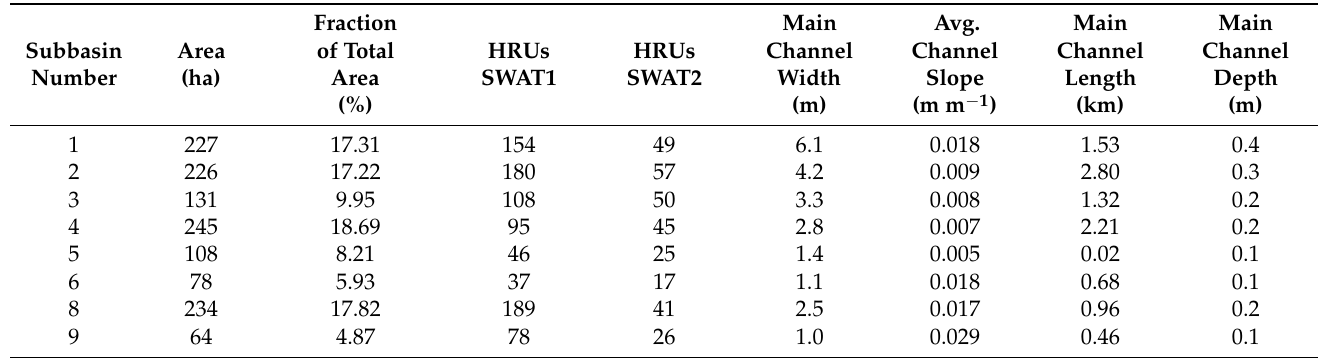
Table 2. Physical characteristics of subbasins and stream attributes of the